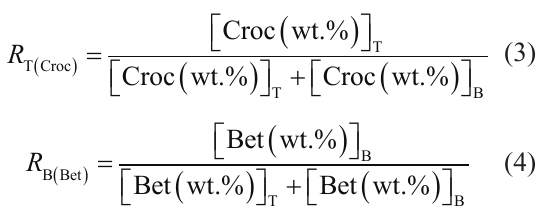
Table 2 – Phase composition, tie-line data of the IL-ATPS formed by [P